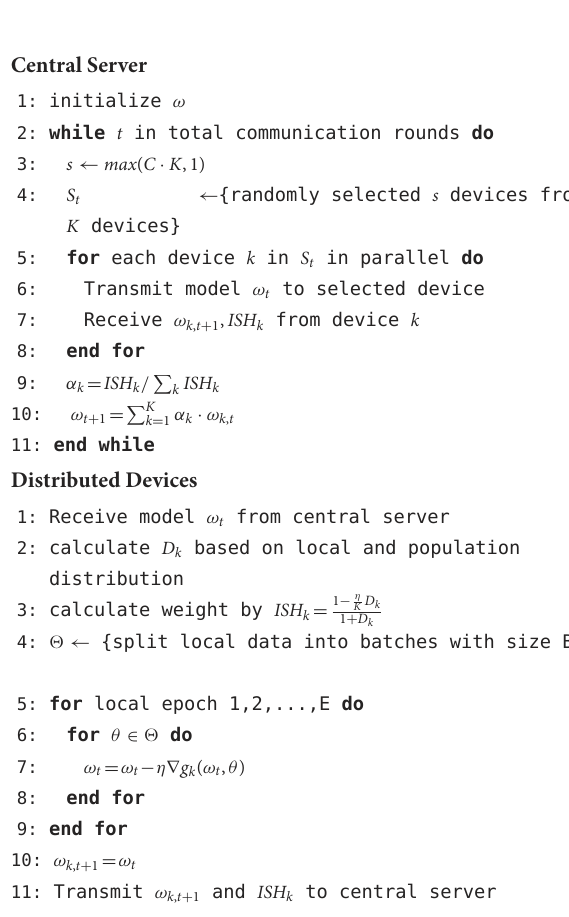
Algorithm 1. Dynamic weighted federated averaging. The K clients are selected from N with the fraction C and are indexed by 1,2,..., k ; learning rate is expressed as η , B and E respectively denote the batch size and training epochs used in local stochastic gradient descent. Specifically, D k denotes the EMD between the data distribution on device k and population